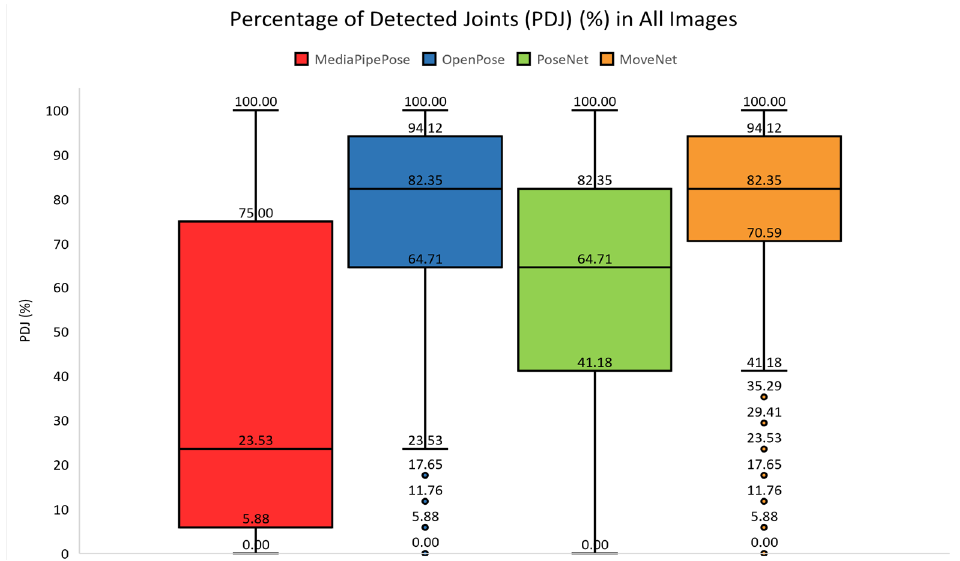
Figure 3. Box plot of PDJ of all images in the image dataset.